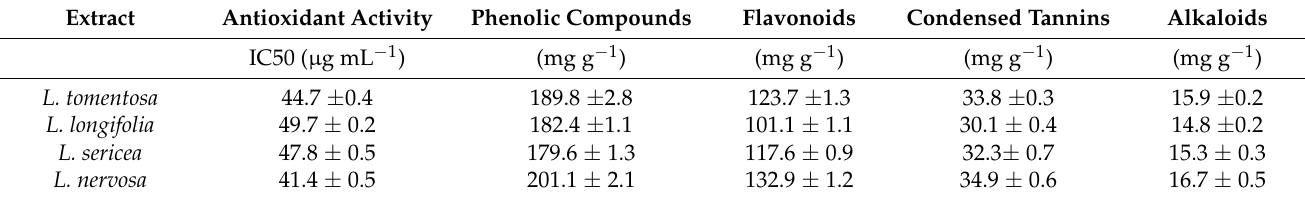
Table 3. Antioxidant activity data (IC 50 —minimum inhibitory concentration), phenolic compounds, flavonoids, condensed tannins, and alkaloids of ethanolic extracts of Ludwigia spp. Extract Antioxidant Activity Phenolic Compounds Flavonoids Condensed Tannins